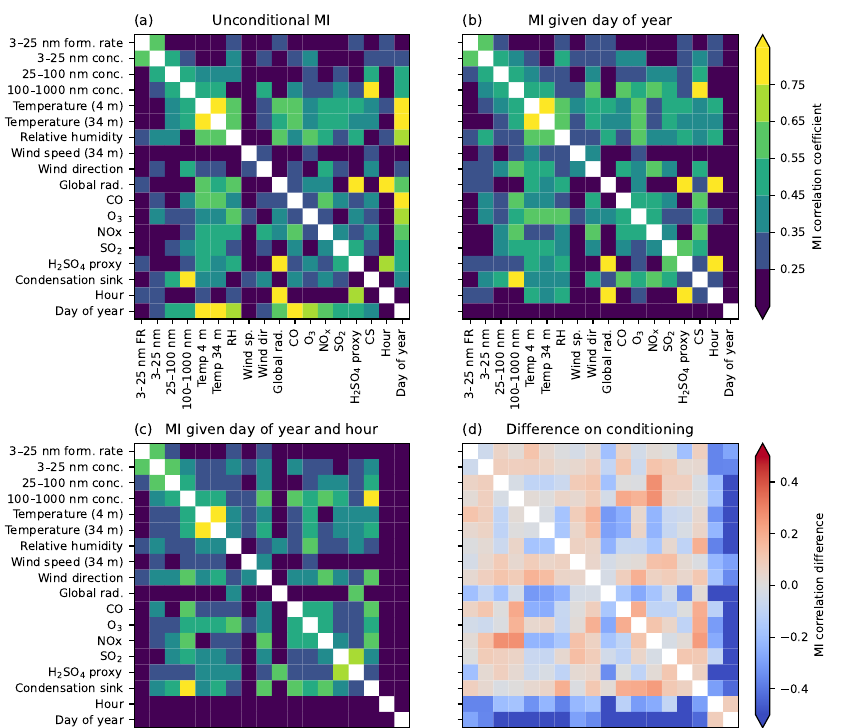
Figure 7. Pairwise MI correlation between a selection of SMEAR II variables. Correlation values below 0.25 are not shown. ( a ) The bottom two rows of unconditional MI indicate that many variables have strong seasonal and diurnal cycles. ( b ) Conditioning on the day of year removes the seasonal cycles. The explanative strength of diurnal cycles is increased. ( c ) Additionally conditioning on the hour removes diurnal cycles as well. The correlations are related to any remaining variation in the variables. Other common factors may still exist, however. ( d ) By comparing subfigures ( a , c ), we see that especially the effect of global radiation is actually explained by date and time. After conditioning, a strong correlation only remains with the sulfuric acid proxy, of which global radiation is an input, and with relative humidity. Conversely, the wind direction (air mass source) gains explanative power when usual yearly variations are removed.